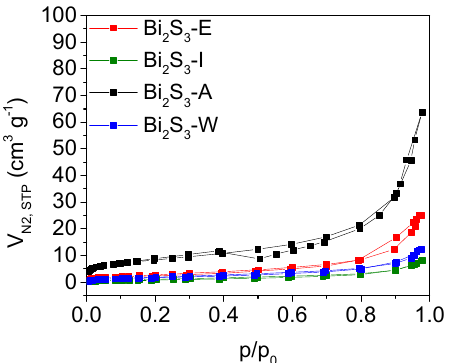
Figure 1. Adsorption/desorption isotherms at 77 K for the bismuth sulfides. Table 1. Obtained porous structure parameters based on the N 2 isotherms for the bismuth sulfides synthesized with different solvents.